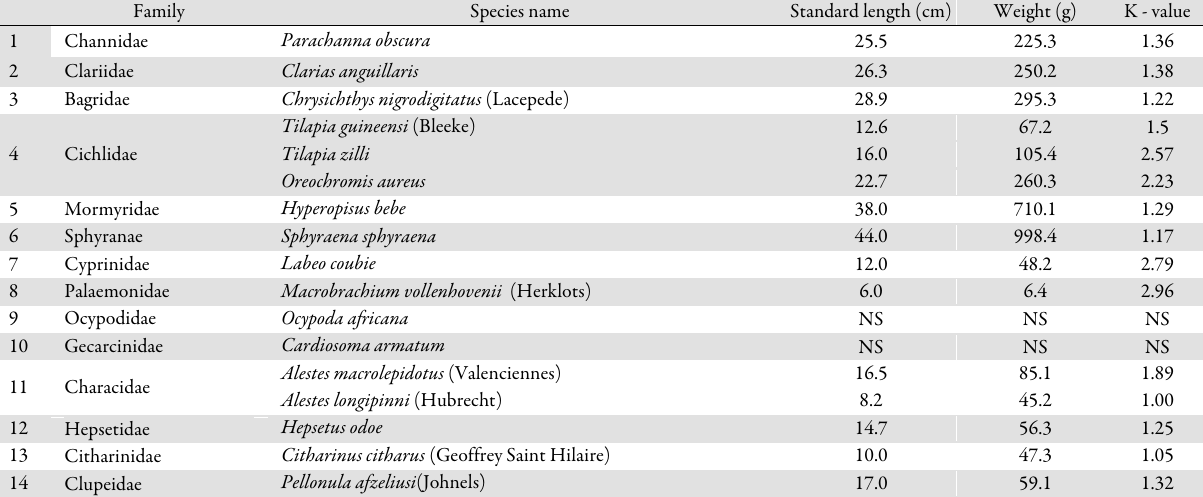
Table 7. The checklist and condition factor (K) of fish species at Ibefun River, Ogun state Family